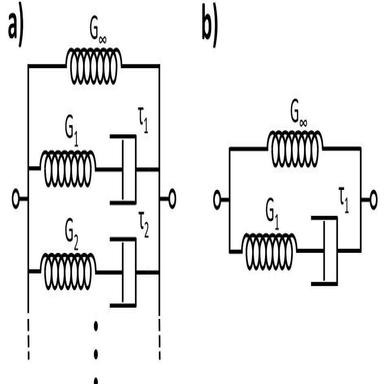
a) Generalized Maxwell model for a soft gel using the spring-dashpot analogy. b) The simplified 3-parameter viscoelastic model.